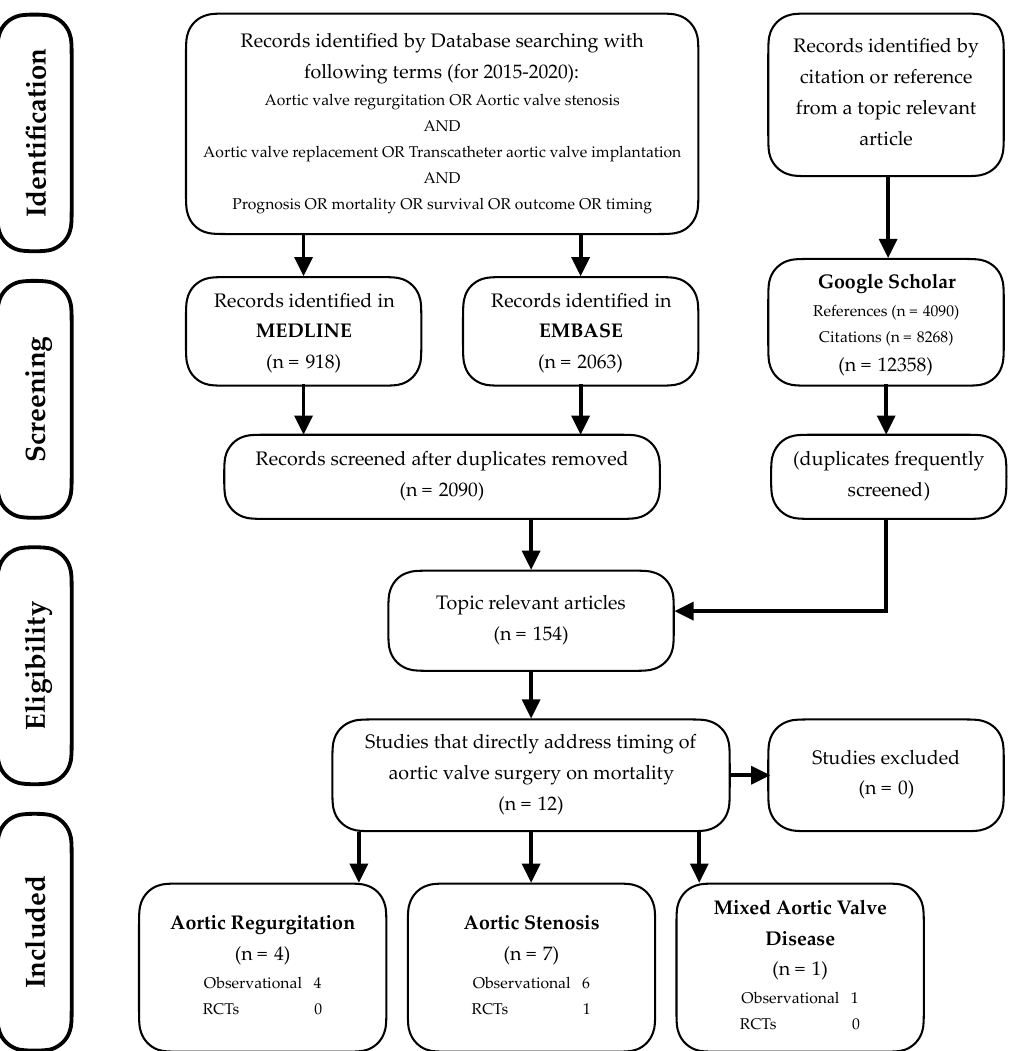
Figure 1. Flowchart of the study selection.